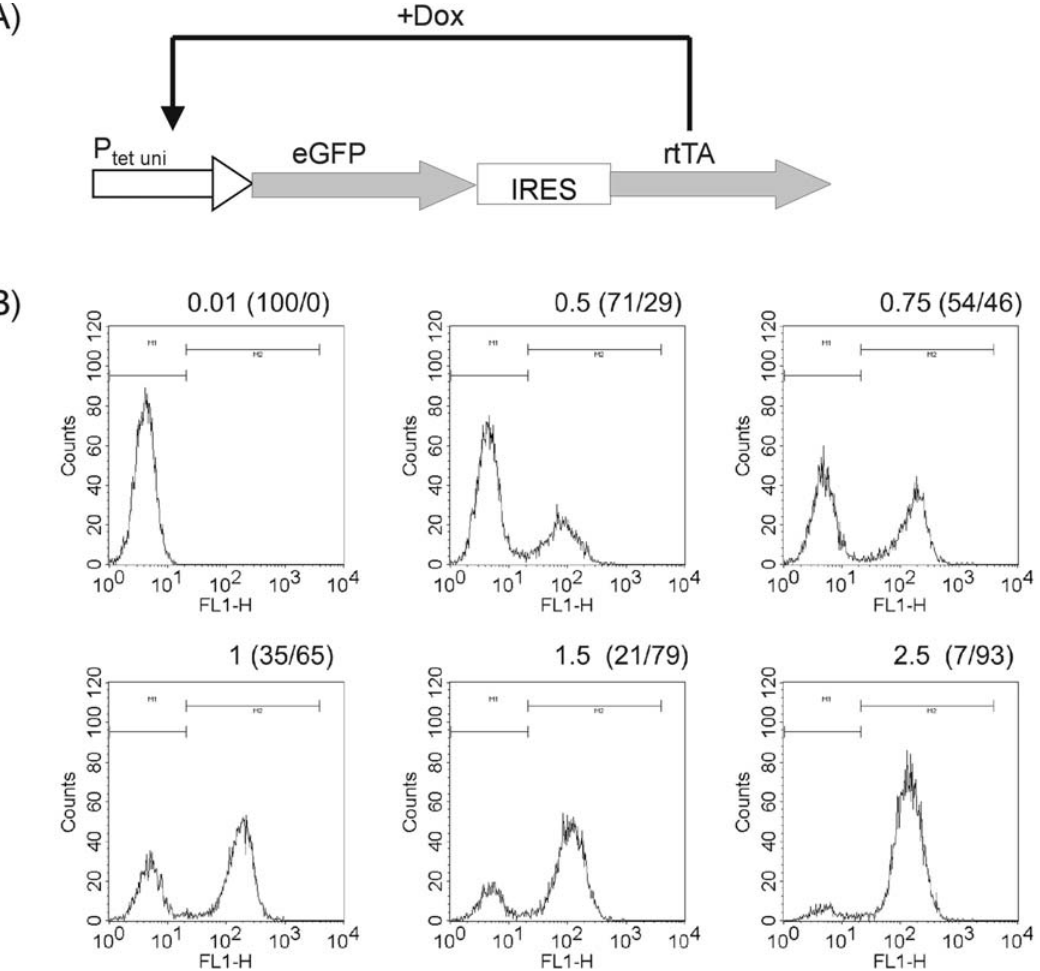
Figure 1. Setup and expression pattern of the positive feedback loop. (a) Vector map of pJSARGFP transducing the positive feedback loop. (b) NIH3T3 cells were stably transduced through lentiviral infection with pJSARGFP. A representative clone was cultivated for four days with the indicated Dox concentrations (in m g/ml) and analyzed for GFP expression using flow cytometry. The numbers in brackets represent the percentage of cells which fall in the respective marker regions. The bimodal response is clearly visible from this data.